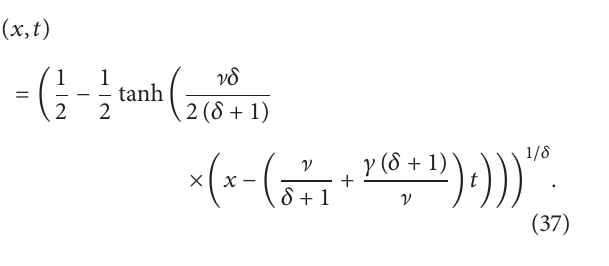
The exact solution of (35)